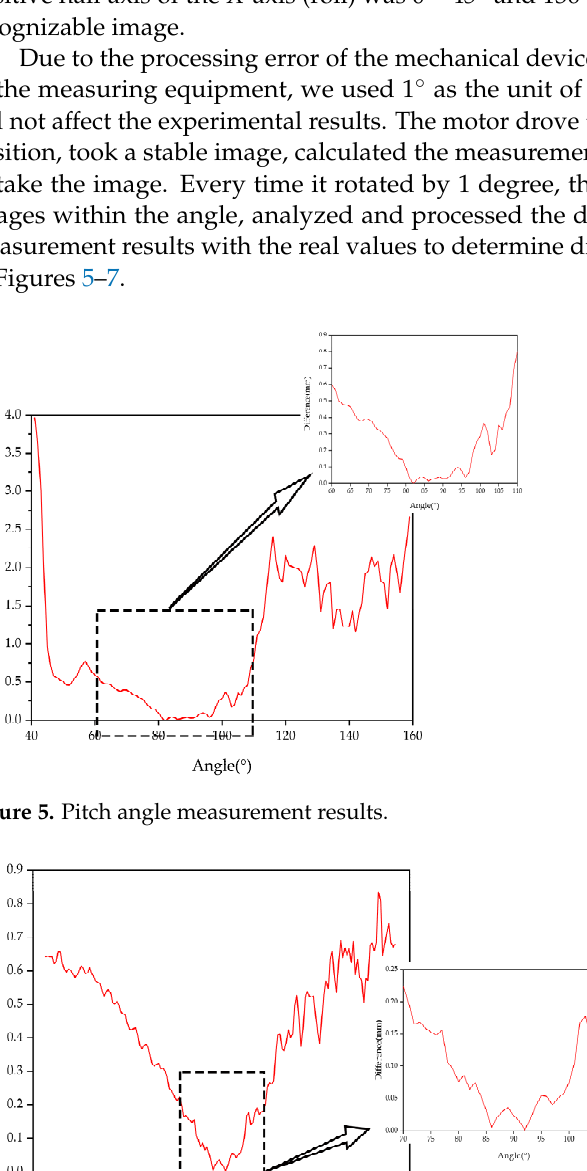
( b ) Figure 7. Tilt angle measurement results: ( a ) 0°~40° and ( b ) 136°~180°. When the pitch angle range is 80~97°, the yaw angle is 80~101°, and the tilt angle is 0~2° and 177~180°, a certain measurement accuracy can be guaranteed to satisfy the meas- urement requirements. Satisfactory experimental results were obtained.